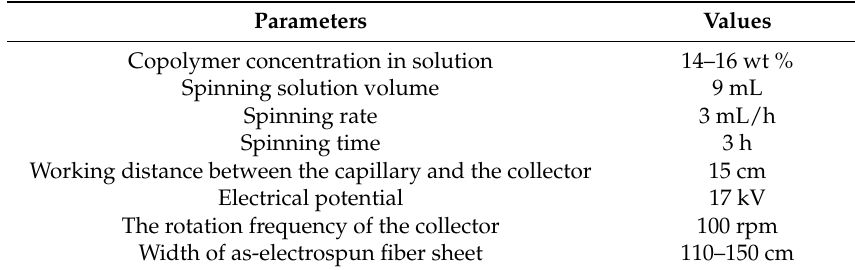
Figure 1. ( a – c ) Processing flows schematically representing the key steps to synthesize as-electrospun cross-linked poly(vinylidene fluoride- co -hexafluoropropene) (PVDF- co -HFP) fibers and their gel polymer electrolytes (GPEs) impregnated with a liquid or ionic electrolyte, and ( d ) a schematic diagram showing the key components of an assembled flexible Li-ion battery (LIB) cell integrated with the ionic-liquid impregnated PVDF- co -HFP fibers. Table 1. Key optimized parameters for the electrospinning to fabricate the cross-linked PVDF- co -HFP fiber